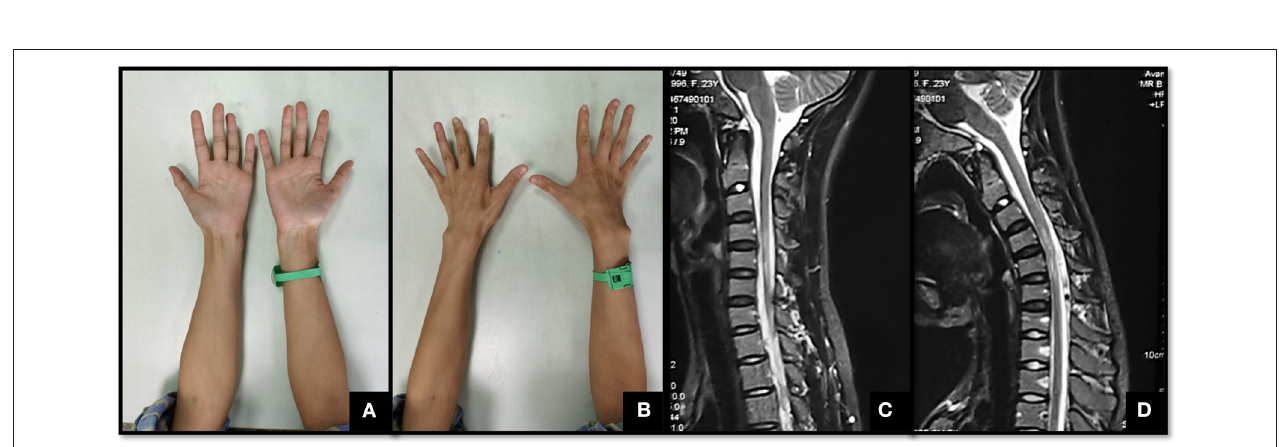
FIGURE 2 | A 24-year-old female with weakness of both hands for approximately 5 years. (A,B) show the atrophy of the left hypothenar and the first dorsal interosseous muscles on both sides. The left upper limb was more severely affected. (C) shows an obviously thin spinal cord with a high signal in T2WI from C4 to C6. (D) shows the cyst–wall separation behind the spinal cord in the cervical flexion position. This patient was bilaterally affected, with one side more severely so. Moreover, her deep tendon reflexes were active and the Hoffmann’s signs of both hands were positive. Therefore, she was classified as having Type II Hirayama disease.